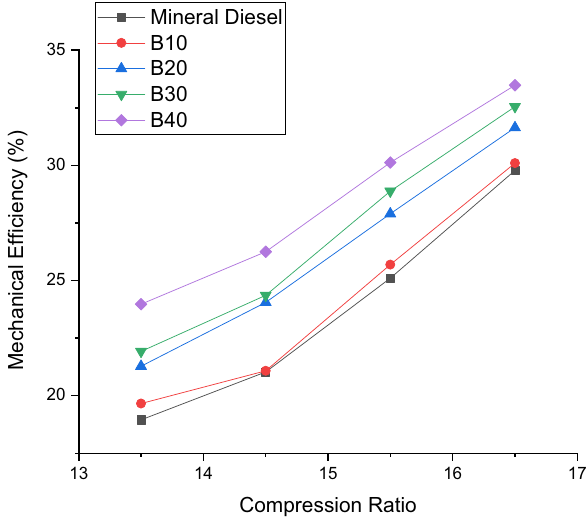
Fig. 7 Variation of In-CPP of dual biodiesel sample blends at differ- ent